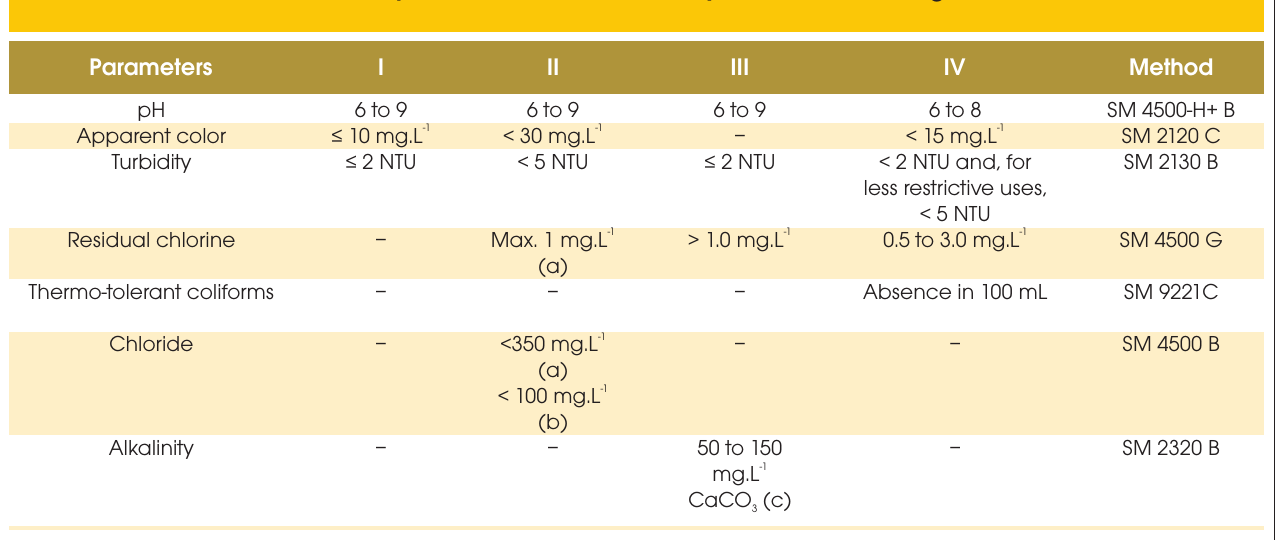
Table 1 – Parameters selected for the evaluation of water quality,